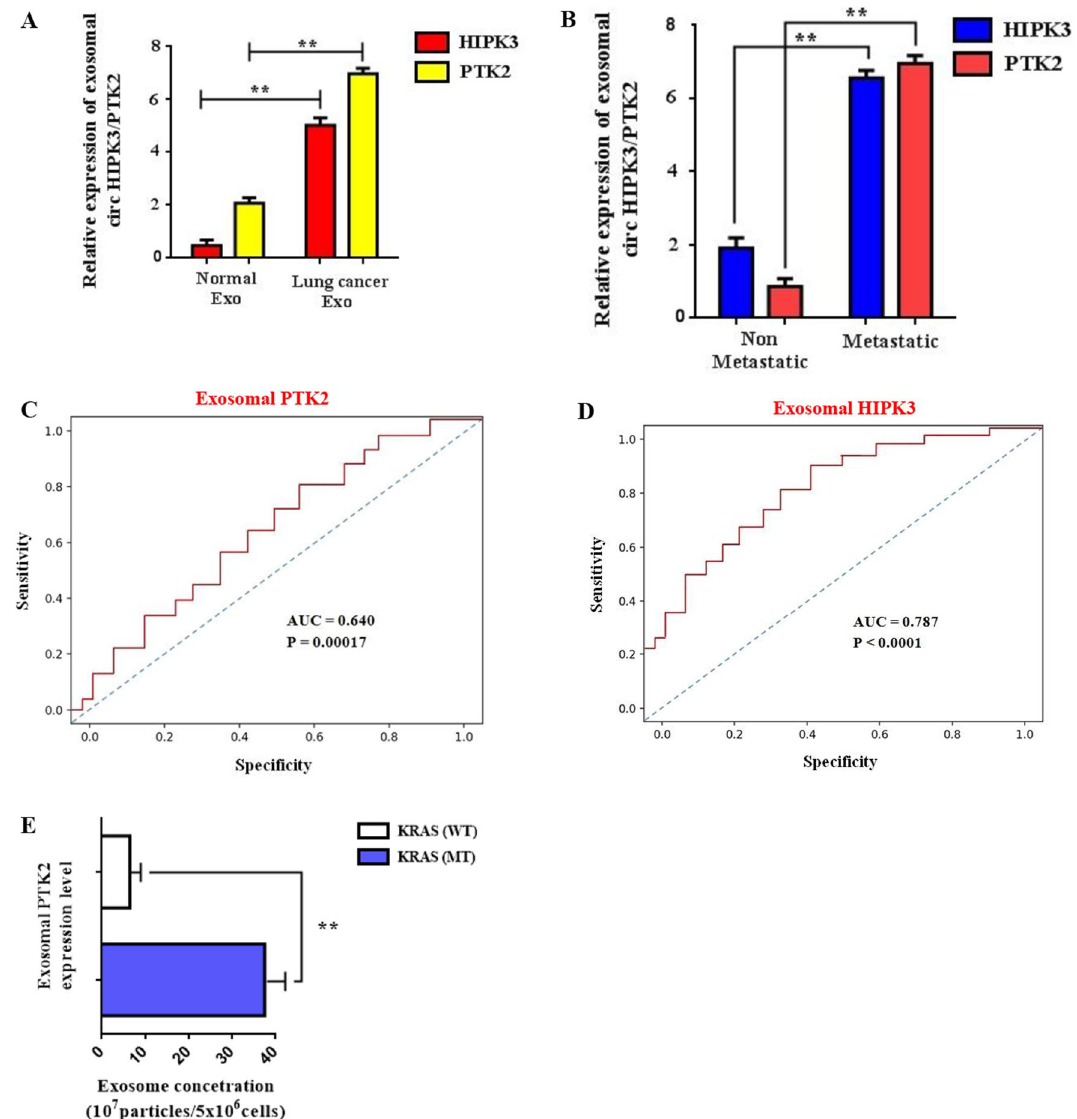
Figure 6. Exosomal expression of circPTK2 triggers an immunosuppressive metastatic circuit. ( A ) Relative exosomal levels of circHIPK3, circPTK2 isolated from patient-derived serum, were measured using RT-PCR. ( B ) Exosomal serum circPTK2/circHIPK3 expression from metastatic (Stage III–IV) and non metastatic (Stage I–II) NSCLC patient groups. ( C , D ) ROC curve analysis and AUC values for circPTK2 and circHIPK3 respectively. Data represent the mean ± SD of three independent experiments (*p < 0.05; **p < 0.01). ( E ) Quantified exosomal circPTK2 expression from Kras (WT) and Kras (MT) patient groups. ( F ) Representative images from migration and invasion assays of H1299 cells after transfection with siRNA against circPTK2 (4 μg) and PLX-3397 M2 inhibitor (25 μΜ) for 24 h. ( G ) Representative images from migration and invasion assays of H1975 cells after transfection with siRNA against Kras (4 μg) and PLX-3397 M2 inhibitor (25 μΜ) for 24 h. ( H , I ) Quantitative analysis of migration and invasion assays following cell transfection. The results represent the mean ± SD of three independent experiments. Differences were considered statistically significant at p < 0.05. Statistically significant data are indicated by asterisks (*p < 0.05, **p <